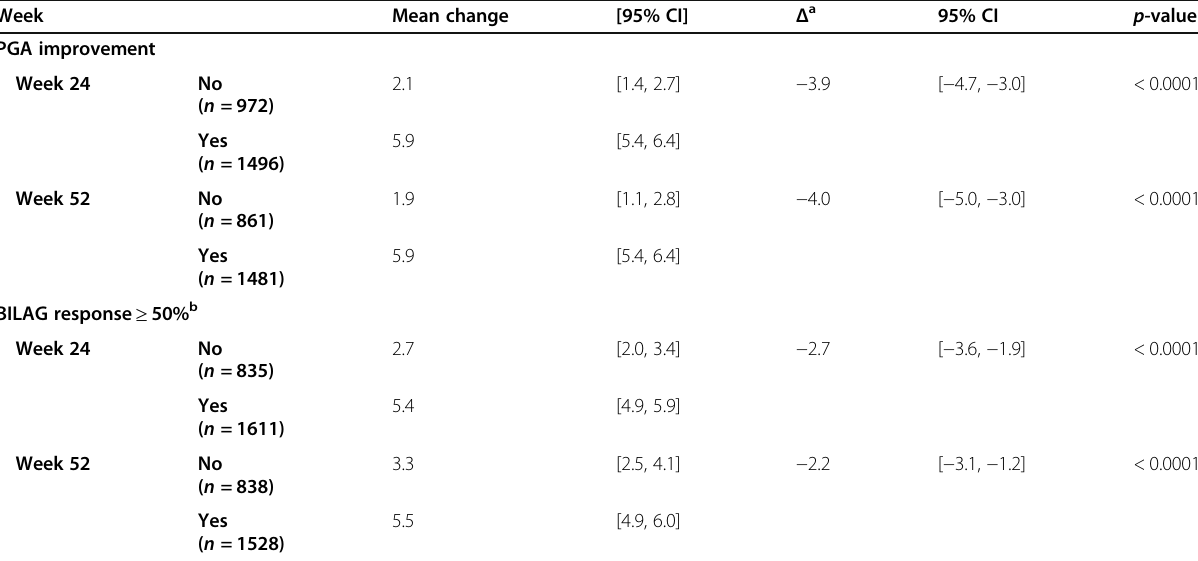
Table 6 Mean change from baseline in FACIT-Fatigue scores by improvement in PGA and BILAG response rate (pooled